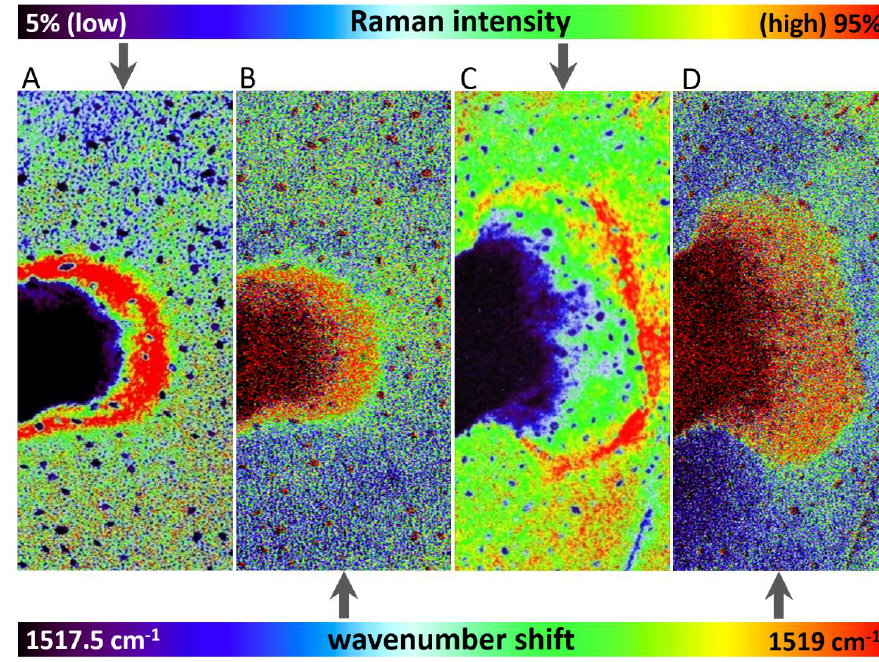
Figure 3. Comparison of Raman signal-to-baseline intensity (A,C) and band wavenumber position (B,D) of the carotenoid ν 1 (C=C) band in altered areas of leaves of Chenopodium album after 48 h (A,B) and 72 h (C,D) of treatment, respectively.